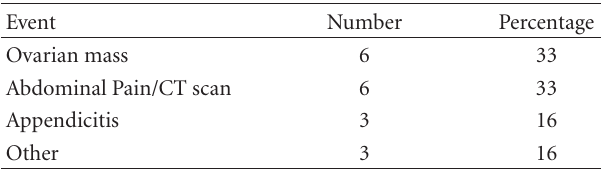
Table 1: Mode of presentation in 18 patients with PMP. Table 2: Characteristics of patients with limited pseudomyxoma peritonei (L-MCP) treated with cytoreductive surgery and HIPEC.